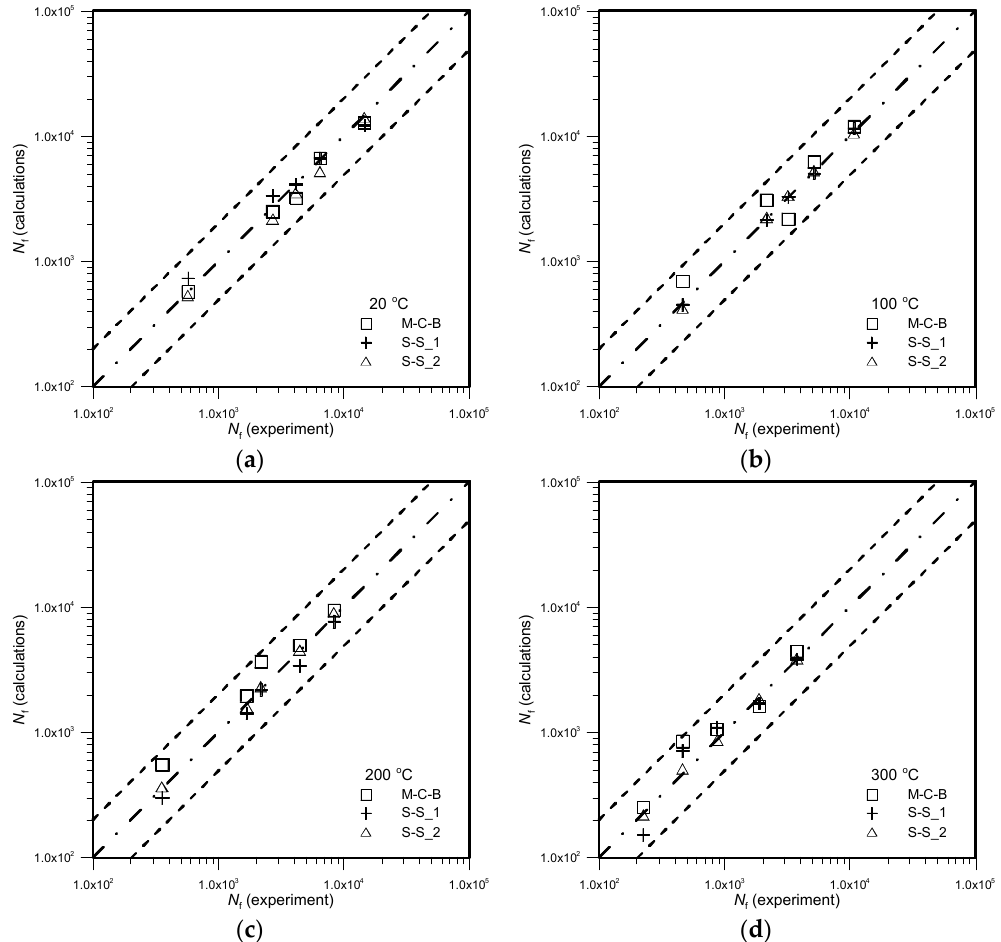
Figure 10. Comparison of numerical simulations of fatigue life with experimental data for uniaxial tension-compression of ENAW2024T3 aluminum alloy samples at elevated temperature: ( a ) 20 °C; ( b ) 100 °C; ( c ) 200 °C, ( d ) 300 °C.